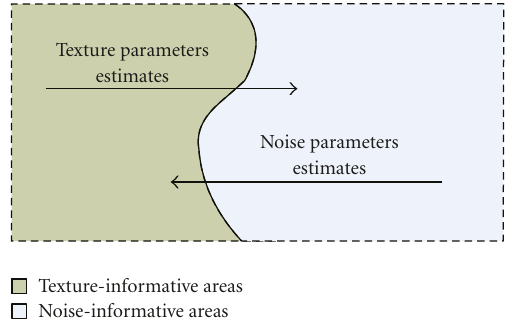
Figure 1: General idea of the proposed noise STD estimation